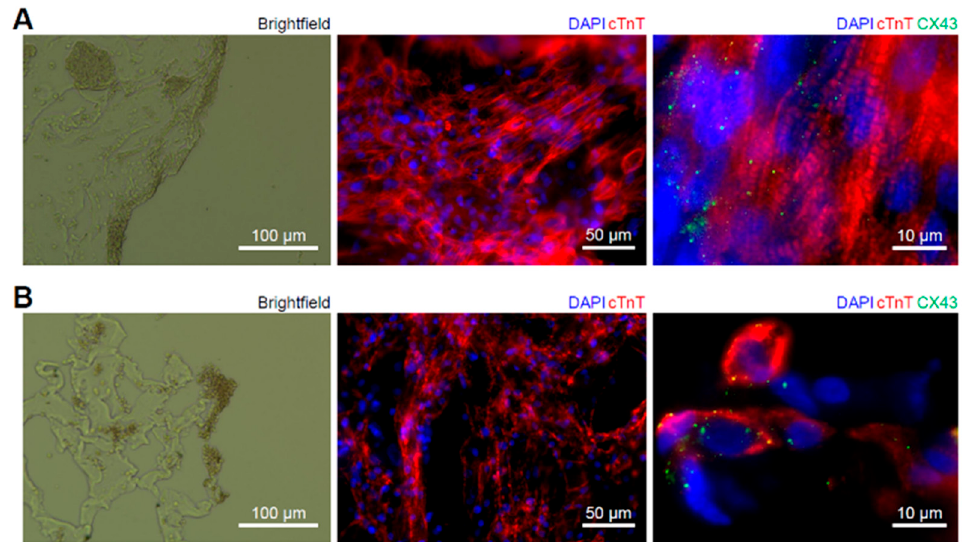
Figure 5. Cell and tissue responses to the cryoablation. ( A ) From left to right, the non-ablated disk under brightfield, staining for cardiac muscle layer via cTnT (cardiac troponin T) and DAPI on the surface of the non-ablated disk, and a high-magnification image of cell structures of the non-ablated disk stained via cTnT, DAPI and CX43 (connexin 43). ( B ) From left to right, the ablated disk under brightfield, staining for cardiac muscle layer via cTnT (cardiac troponin T) and DAPI on the surface of the ablated disk, and a high-magnification image of cell structures of the ablated disk stained via cTnT, DAPI and CX43.